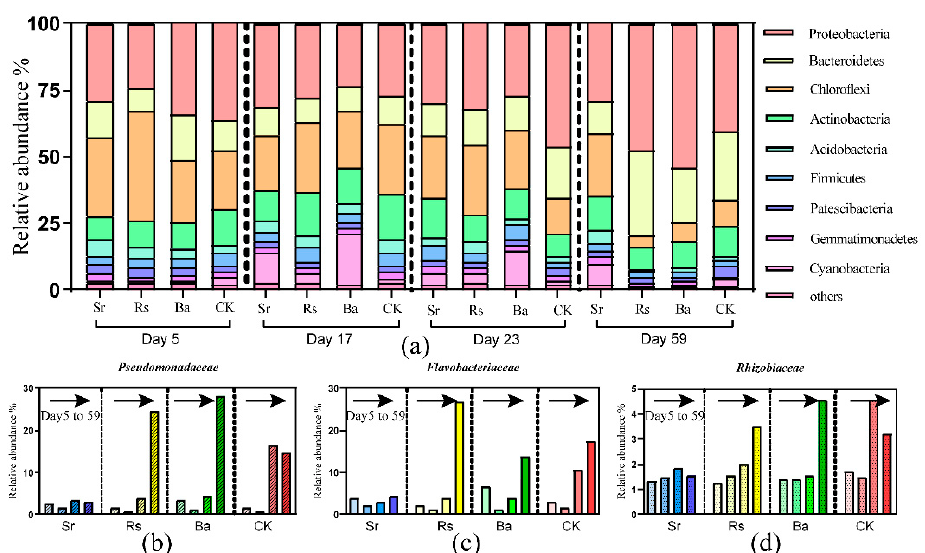
Figure 3. ( a ) Taxonomic comparison with relative abundance at the phylum level under the four treatments during four plant growth stages; ( b ) Change in the relative abundance of Pseudomonadaceae under the four treatments during four plant growth stages; ( c ) Change in the relative abundance of Flavobacteriaceae under the four treatments during four plant growth stages; ( d ) Change in the relative abundance of Rhizobiaceae under the four treatments during four plant growth stages.